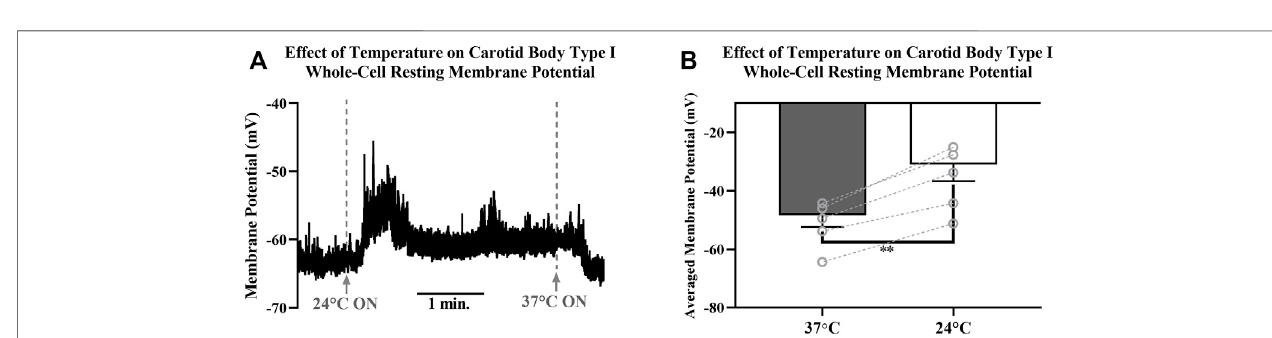
FIGURE7|(A) Example trace showingtheeffectdecreasingtemperature ofextracellularHEPES-buffered solutionhasonresting membrane potentialofaCarotid BodyTypeIcellmeasuredviaperforated-patchwhole-cellcurrent-clamprecordings.Solutionswereinitially37 ° C,wereswitchedtoa24 ° Csolutionatthe fi rstdottedline and then returned to 37 ° C at the second dotted line. Reversible depolarizations were consistently observed when solution temperature was decreased from 37 ° C to 24 ° (B) Decreasing temperature of extracellular HEPES-buffered solution from 37 ° C to 24 ° C caused signi fi cant membrane depolarization in isolated Carotid Body Type I cells (-48.4 ± 4.1 mV vs. − 31.0 ± 5.7 mV; n = 5; p < 0.01) measured in perforated-patch whole-cell current-clamp (I = 0 mode)